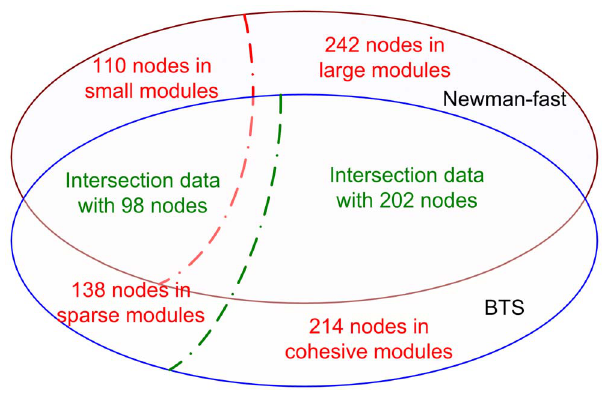
Figure 2. Distributions of nodes in A00 network mined by BTS method and Newman-fast